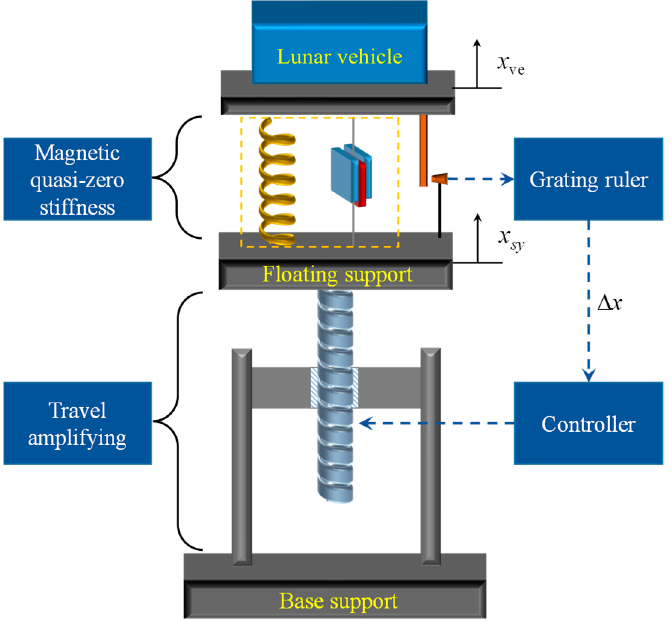
Figure 4. Schematic diagram of the lunar vehicle test system.